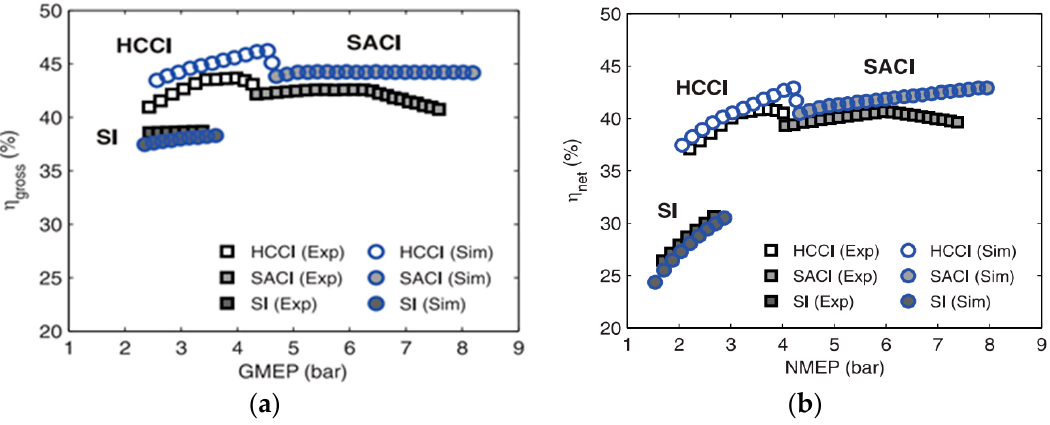
Figure 12. Comparison of simulation and experimental gross and net thermal efficiency vs. load [225]. ( a ) Gross indicated thermal efficiency (GIE) ( b ) Net indicated thermal efficiency (ITE net )